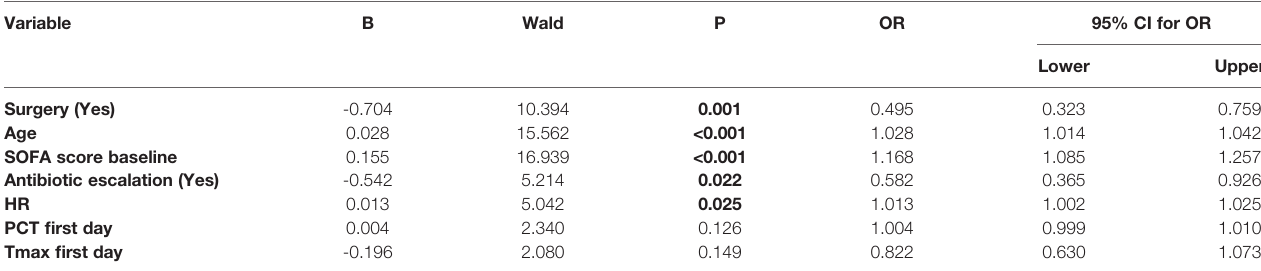
TABLE 2 | Multivariable logistic regression after backward elimination.